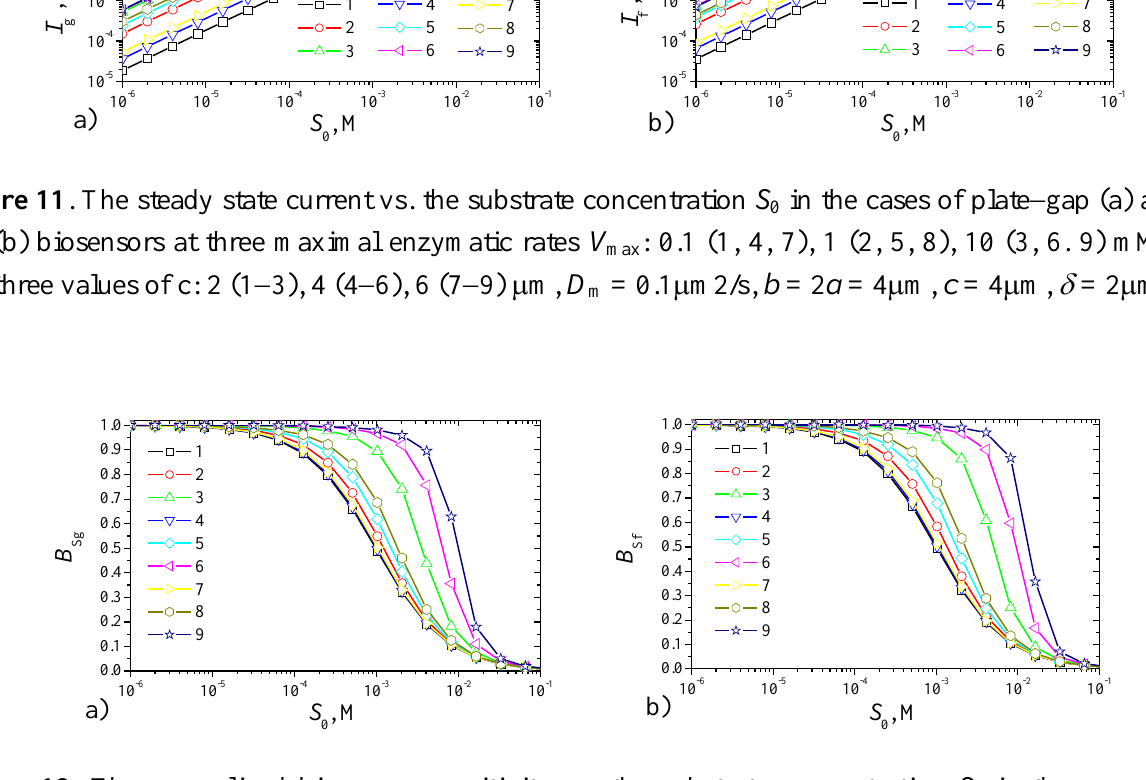
Figure 12 . The normalized biosensor sensitivity vs. the substrate concentration S plate − gap (a) and flat (b) biosensors. The parameters and notations are the same as in Fig. 11. As it is possible to notice in Fig. 13, T